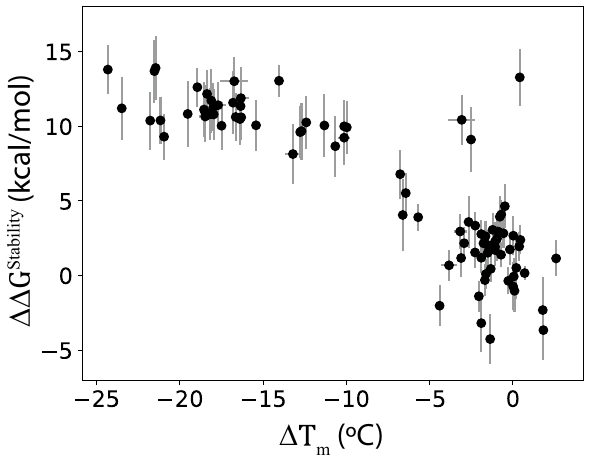
Figure 7. The predicted (cid:31)(cid:31) G Stability for the m396 multi-point mutants from the FEP simulations vs. the shift of their experimentally measured melting temperature relative to the wildtype m396. Some of the horizontal error bars are smaller than the size of the data marker and are thus